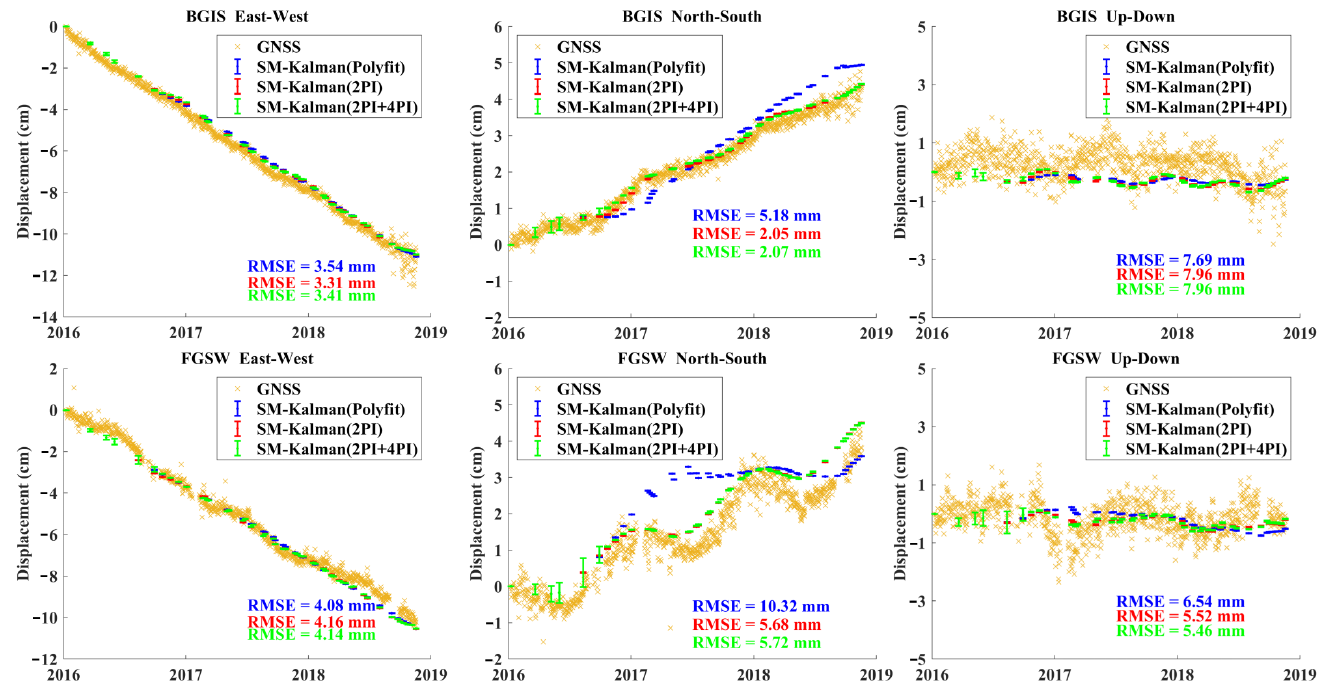
Figure 13. Comparison of the GNSS results with the deformation time series provided by SM-Kalman for three different fitting